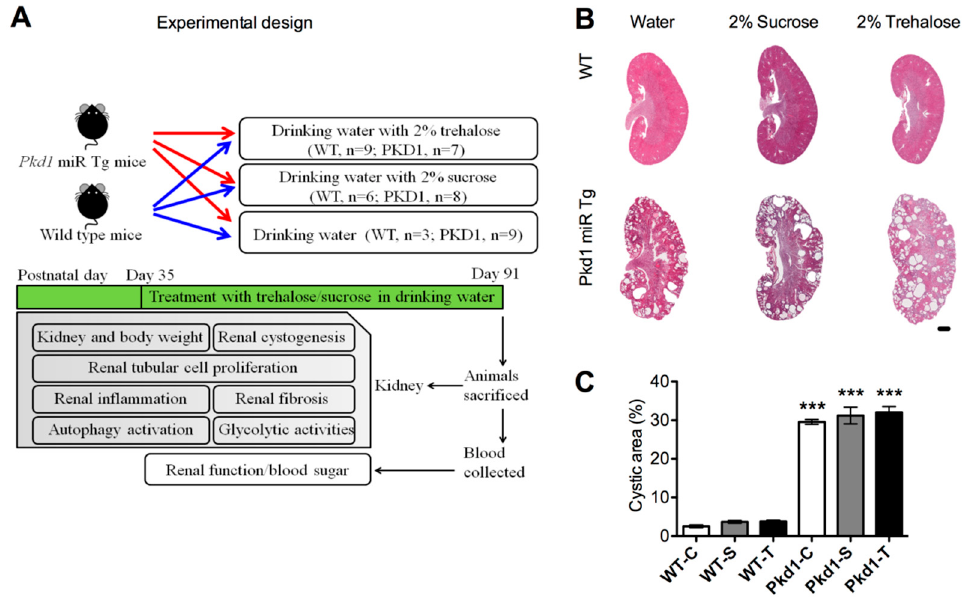
Figure 1. Effect of trehalose treatment on renal cyst formation in Pkd1 miRNA transgenic mice. ( A ) Schematic diagram summarizes the experimental design. ( B ) Representative kidney sections stained with hematoxylin and eosin and ( C ) renal cystic indices of three-month-old Pkd1 miR Tg mice of the different treatment groups ( n = 3, 6, 9, 9, 8, and 7 per group, respectively). Data represent mean ± standard error of the mean. *** p < 0.001 compared with the wild-type control group. WT, wild-type; PKD, polycystic kidney disease; Tg, transgenic; C, control; S, sucrose; T, trehalose. Scale bar, 1 mm.